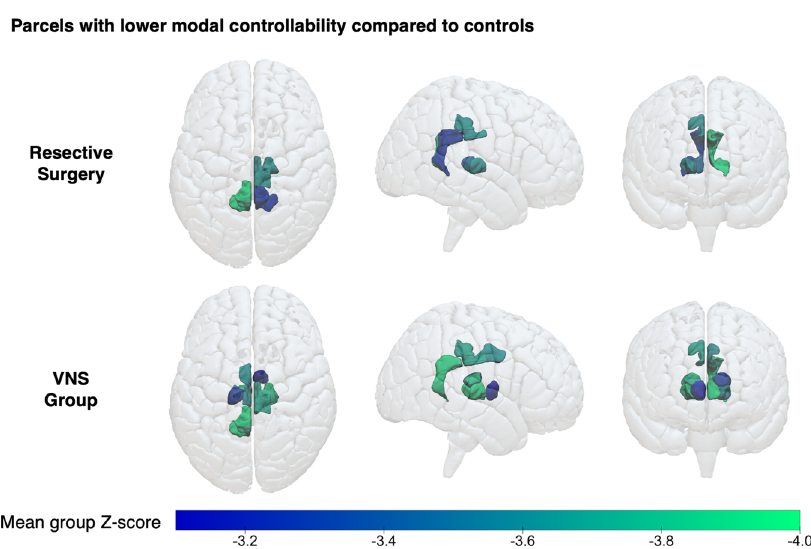
with signi fi cantly lower modal controllability (mean Z scores < − 3.1) in the resective surgery and VNS groups. Note the concentration of parcels around the thalamic nuclei and posterior cingulate cortices. The exact parcels are detailed in Table 1.